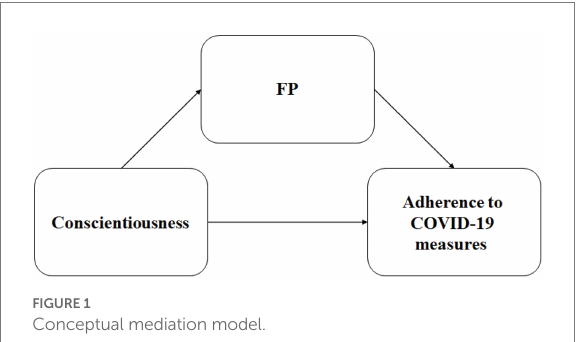
FIGURE 1 Conceptual mediation